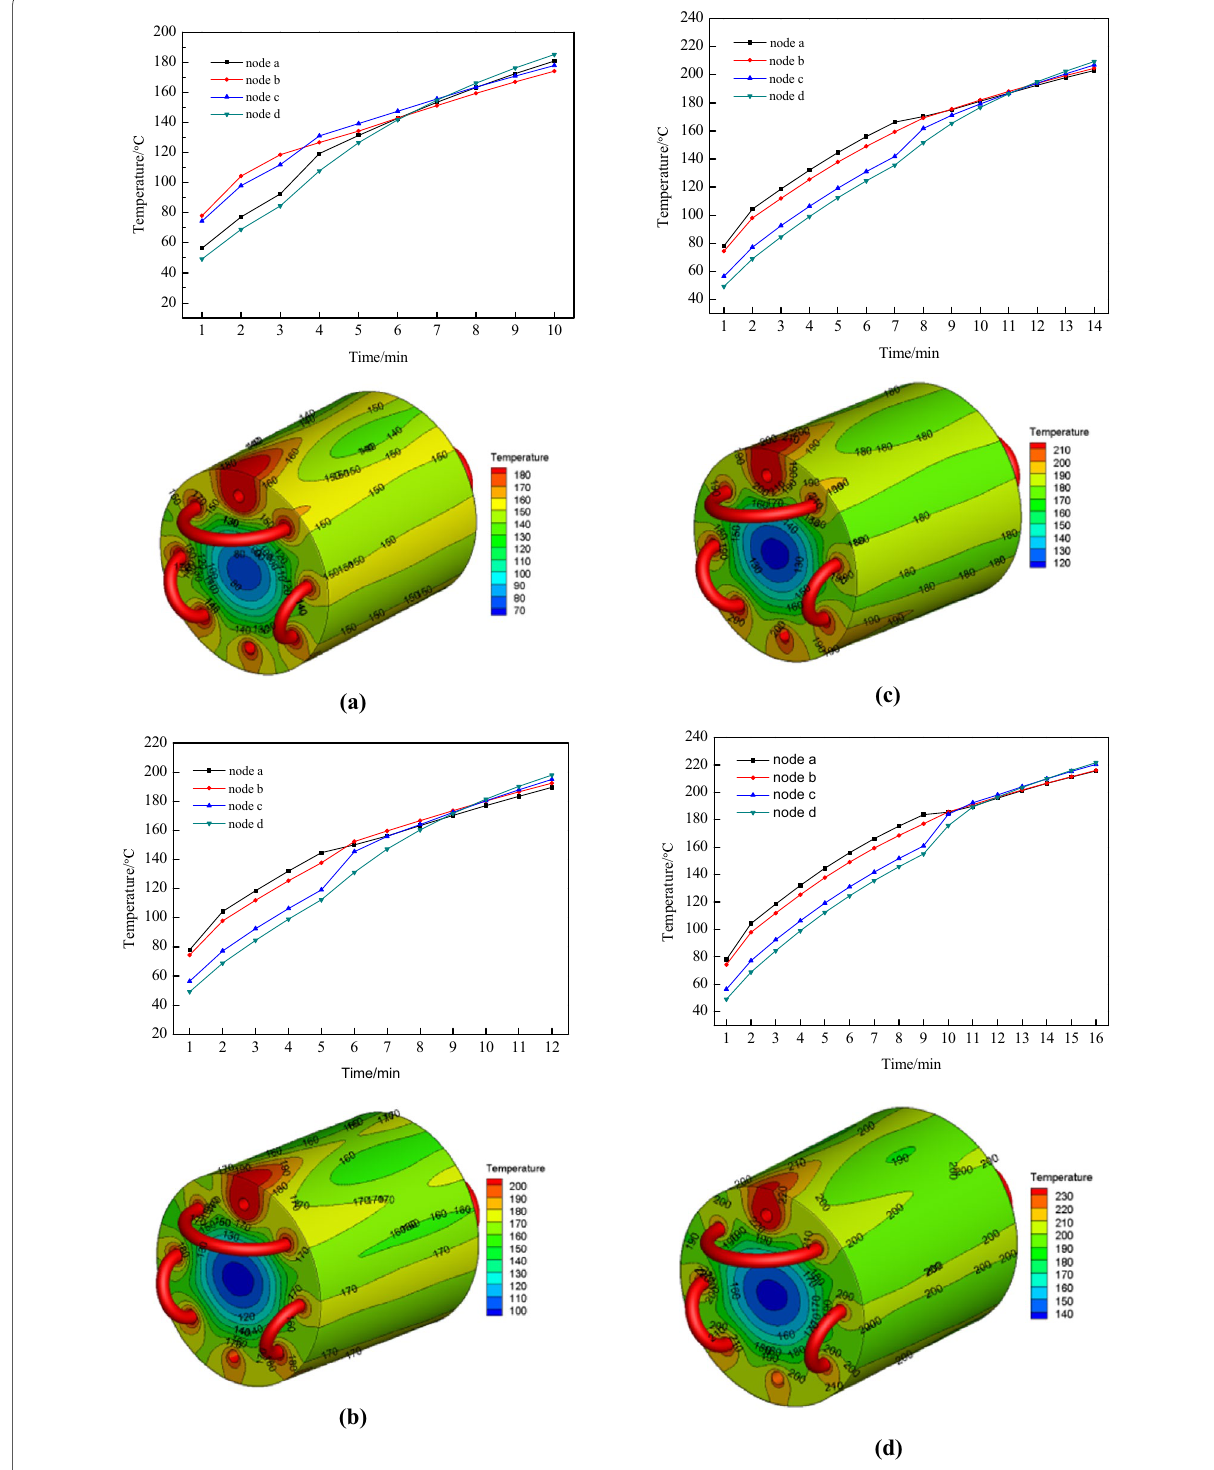
Figure 13 Temperature value of the points a, b, c, and d under different forward flow times: a t